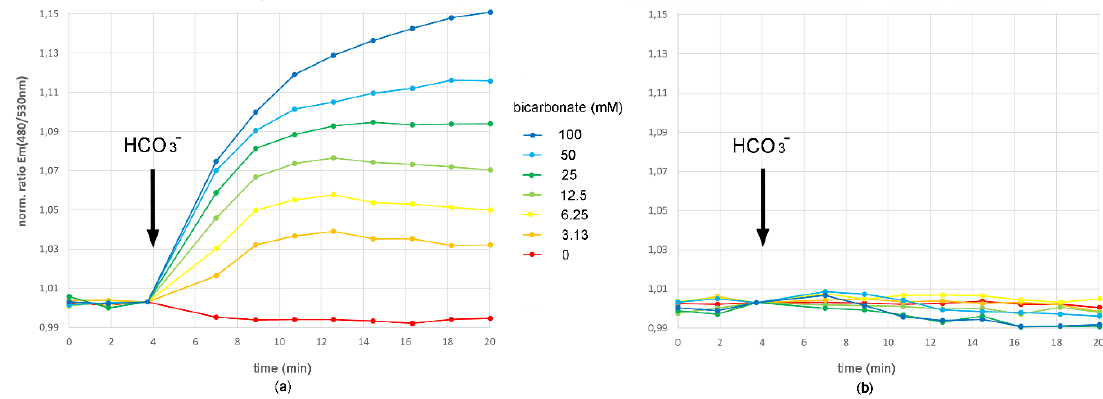
Figure 3. Bicarbonate biosensor assay. The bicarbonate sensory cellular test system measures bicarbonate influx in a concentration-dependent manner in a range from 0 to 100 mM bicarbonate. Upon addition of bicarbonate to the assay buffer, an intracellular increase in bicarbonate concentration resulted in an increase in the fluorescence emission ratio Em(480 nm/530 nm) when exited at 430 nm in ( a ) the CHO-K1 cell expressing both, the bicarbonate sensor sAC tr and the cAMP reporter CEPAC. This ratio increase was dependent on the intracellular increase in cAMP concentration catalyzed by sAC tr , since ( b ) a control cell expressing only the CEPAC reporter without concomitant sAC tr expression showed no bicarbonate-dependent increase in the fluorescence emission ratio upon bicarbonate addition. Data are expressed as mean (n = 6).